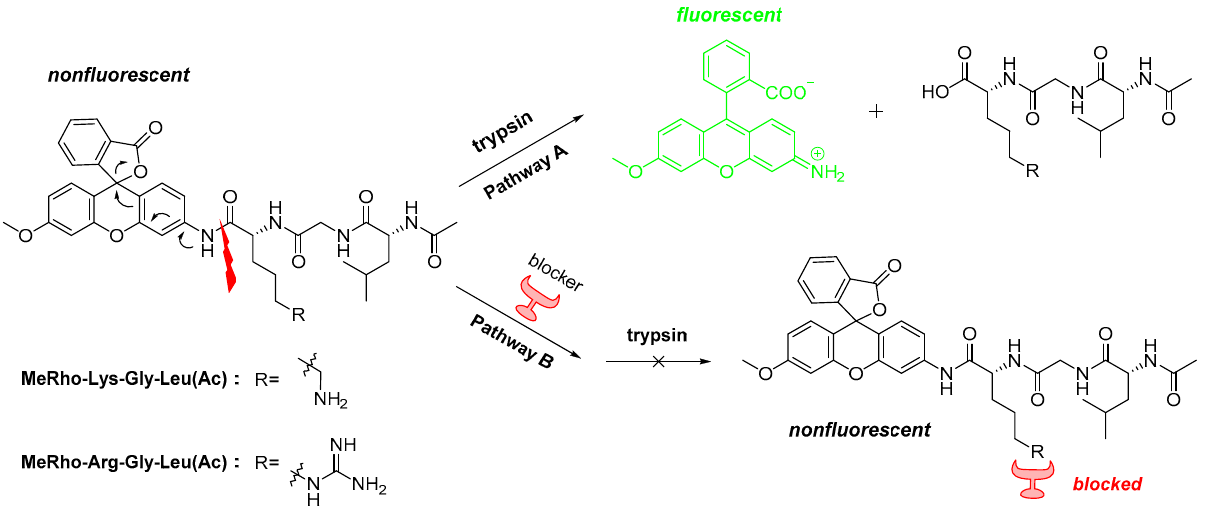
Figure 2. Mechanism of action of fluorogenic peptide substrate modification during the fluorogenic assay. Pathway A: Proteolysis of a fluorogenic peptide substrate by trypsin induces the increase in fluorescence by release of fluorophore. Pathway B: Blocking of an amino acid at the proteolytic site of the fluorogenic peptide substrate showed a maintained fluorescence or relatively decreased fluorescence compared Path A owing to inhibition of proteolysis.